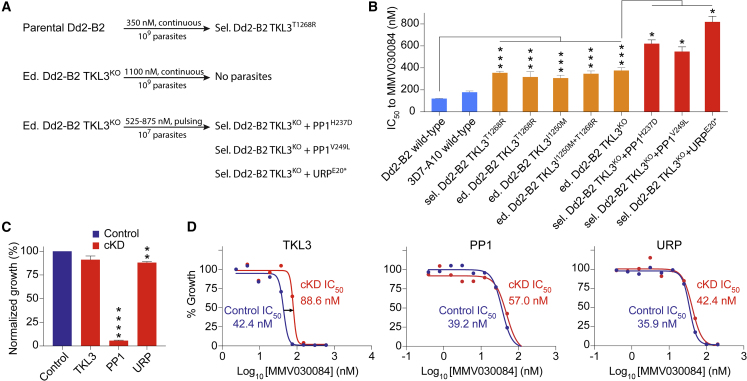
Resistance Selections with Cultured Pf ABS Parasites Identify TKL3, PP1, and URP as Low-Level Resistance Mediators for MMV030084(A) Outline of the MMV030084 resistance selection attempts that identified TKL3, PP1, and URP as candidate resistance mediators.(B) Susceptibility of the selected and confirmatory gene-edited clones to MMV030084. Error bars indicate the SEM based on ≥4 independently repeated experiments with technical duplicates. p values are based on Mann-Whitney U tests (Table S1 (I)).(C) Parasite growth is only minimally inhibited by cKD of TKL3 and URP, while cKD of PP1 renders ABS parasites effectively non-viable (Table S1 (F)). Error bars indicate the SEM based on two independently repeated experiments with technical duplicates. p values are based on unpaired t tests.(D) cKD of TKL3 decreased parasite susceptibility to MMV030084, whereas cKD of PP1 and URP showed no effect. Error bars indicate the SEM based on two independently repeated experiments with technical duplicates. p values are based on unpaired t tests (Table S1 (G)). Sel., selected; Ed., CRISPR/Cas9 edited; aTc, anhydrotetracycline; TKL3, tyrosine kinase-like protein 1 (PF3D7_1349300); PP1, protein phosphatase 1 (PF3D7_1414400); URP, ubiquitin regulatory protein (PF3D7_0808300); cKD, conditional knockdown; ∗p < 0.05, ∗∗p < 0.01, ∗∗∗p < 0.001, ∗∗∗∗p < 0.0001.